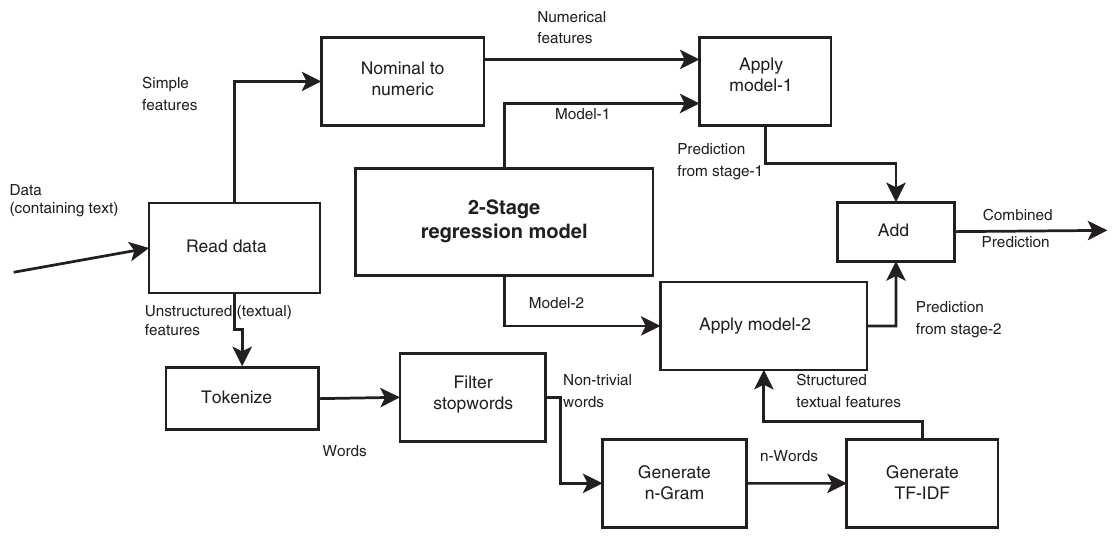
Figure 2: The Data Mining Process to Apply the Two-Stage Regression Model. Each stage predicts a component of the value, and the two components are summed to generate the final